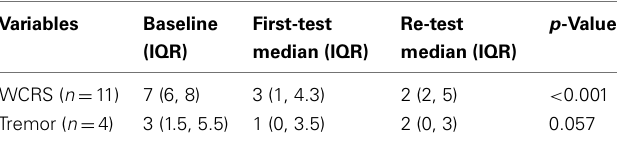
Table 1 | Comparisons ofWCRS and tremor